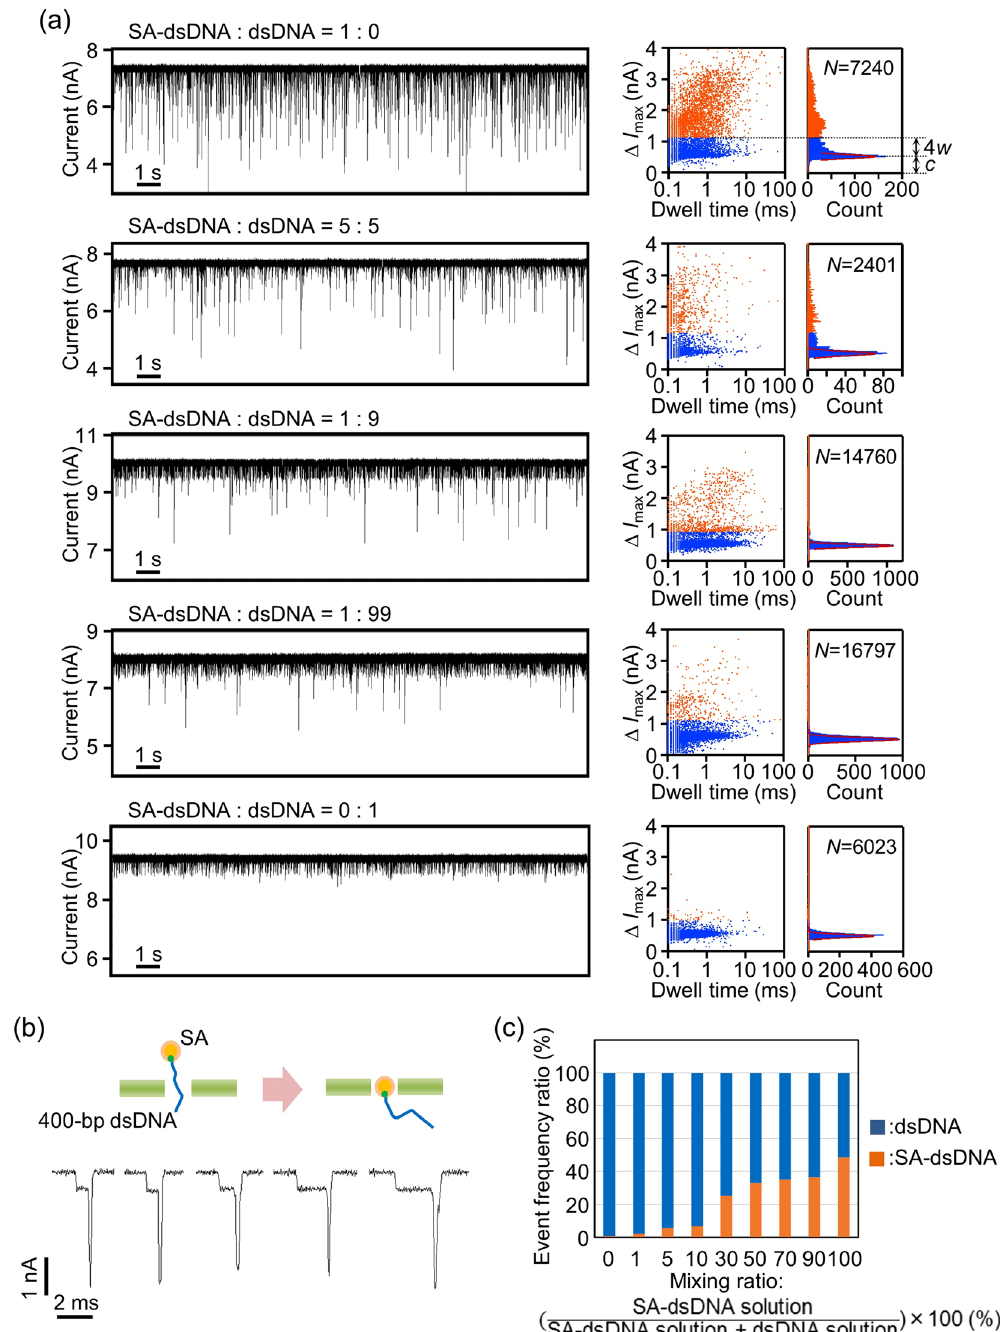
Figure 8. Analysis of current-blockade events derived from SA-labelled and non-labelled dsDNA passing through nanopores at various mixing ratios of SA-labelled and non-labelled dsDNA. ( a ) Time traces of ionic current through nanopores fabricated in 14-nm-thick SiN membranes, scatter plots of current-blockade events and histograms of Δ I max . The voltage applied was 0.2 V ( V trans = 0.2 V and V cis = 0 V). Among nine experiments, the results for five different mixing ratios of SA-labelled 400-bp dsDNA and 400-bp dsDNA are shown. The estimated diameters of the nanopores were 8.8 nm, 9.1 nm, 10.8 nm, 9.4 nm and 10.4 nm in order from the top to the bottom. ( b ) Magnified views of typical ionic-current blockades caused by SA-labelled 400-bp dsDNA passing through a nanopore. ( c ) Frequency ratios of current-blockade events derived from SA-labelled and non-labelled dsDNA passing through nanopores at nine different mixing ratios of SA-labelled and non-labelled